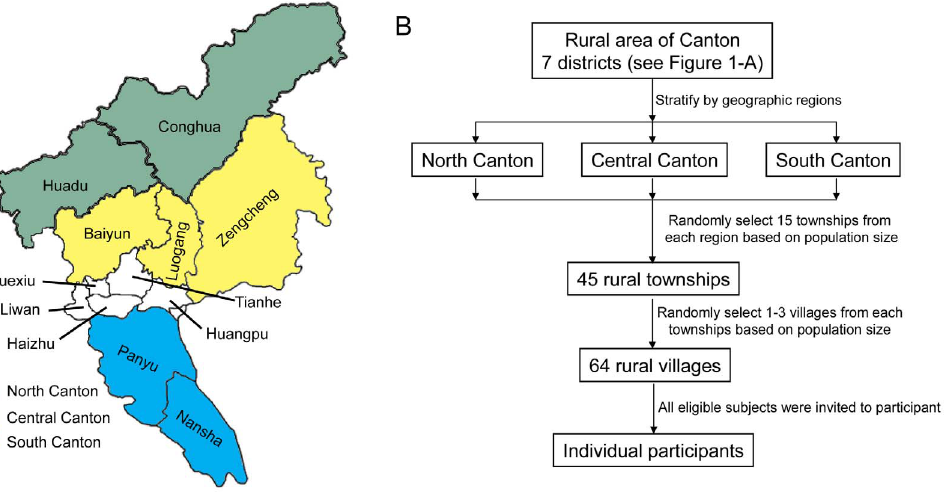
Figure 1. Districts and geographical areas (A) and flowchart (B) of the multistage stratified sampling procedure in the Rural Canton Diabetes and Metabolic Disorders Study (RCDMDS).